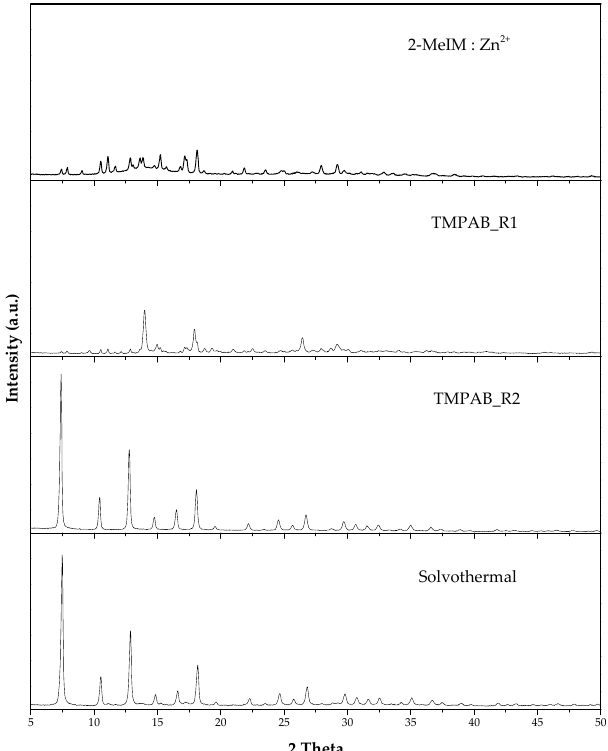
Figure 1. XRD patterns of synthesized zeolitic imidazolate framework-8 (ZIF-8) samples obtained from route 1 (R1) and route 2 (R2) compared with solvothermal method.